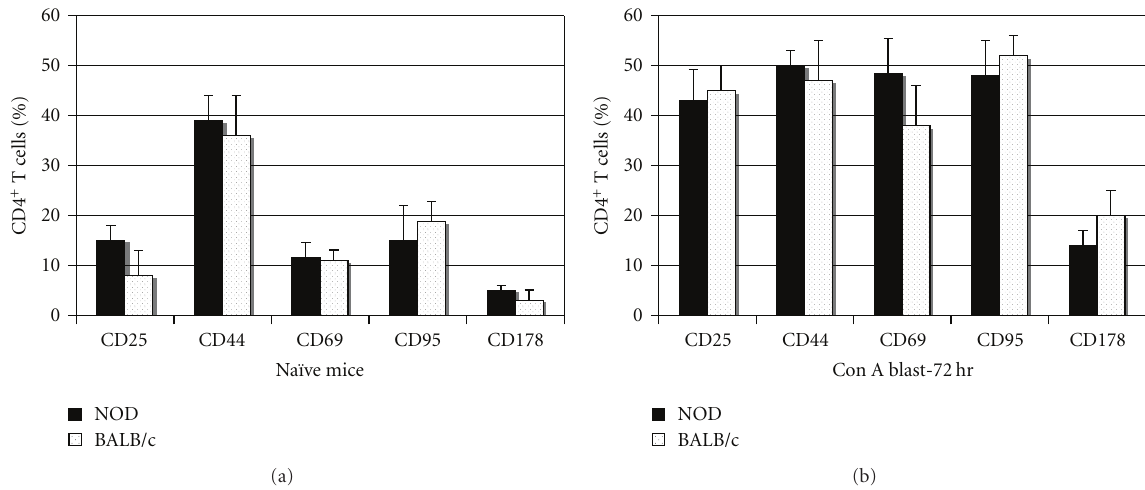
Figure 2: The expression of CD25, CD44, CD69, CD95, and CD178 is similar on NOD and BALB/c CD4+ spleen cells. Naive spleen cells or live Con A blasts (harvested by histopaque separation 72 hrs after stimulation) from groups of 3 NOD or BALB/c mice were examined individually by flow cytometry for the expression of cell surface molecules associated with activation. The data are expressed as the mean percentage of CD4+ cells (gated) that were positive for the respective molecule in groups of 3 mice, and the results are representative of 3 experiments, with at least 20,000 events collected in each